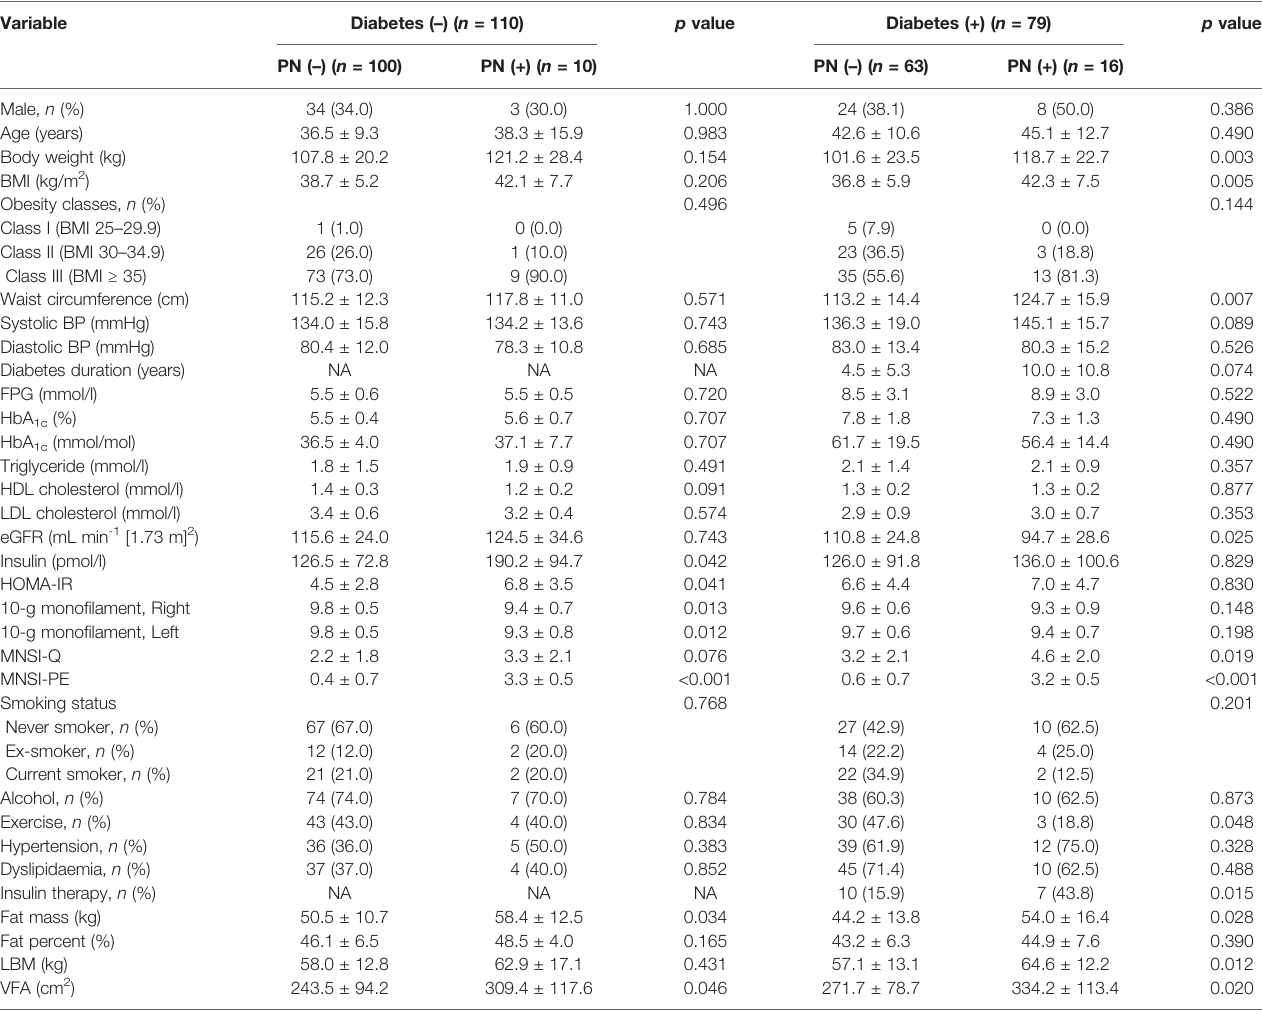
TABLE 1 | Baseline characteristics of obese subjects strati fi ed by diabetes and polyneuropathy. Variable Diabetes ( – ) ( n = 110) p value Diabetes (+) ( n = 79)